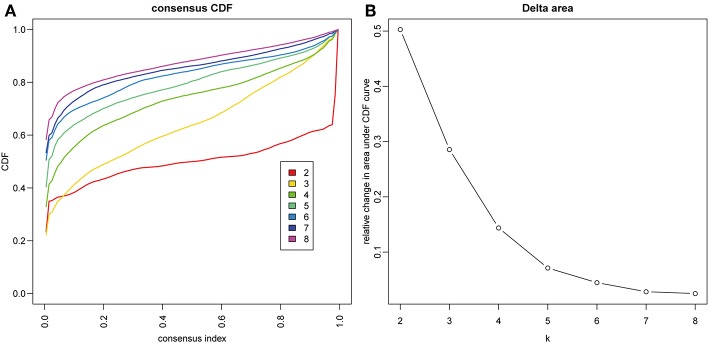
Identification of immune-associated subtypes of HCC in TCGA cohort. (A) The cumulative distribution function (CDF) curves is the integral of probability density function, which can completely describe the probability distribution of a real random variable, and established using consensus clustering approach. CDF curves of consensus scores based on different subtype number (k = 2, 3, 4, 5, 6, 7, 8) and the corresponding color are represented. (B) The CDF Delta area curve of all samples when k = 4.